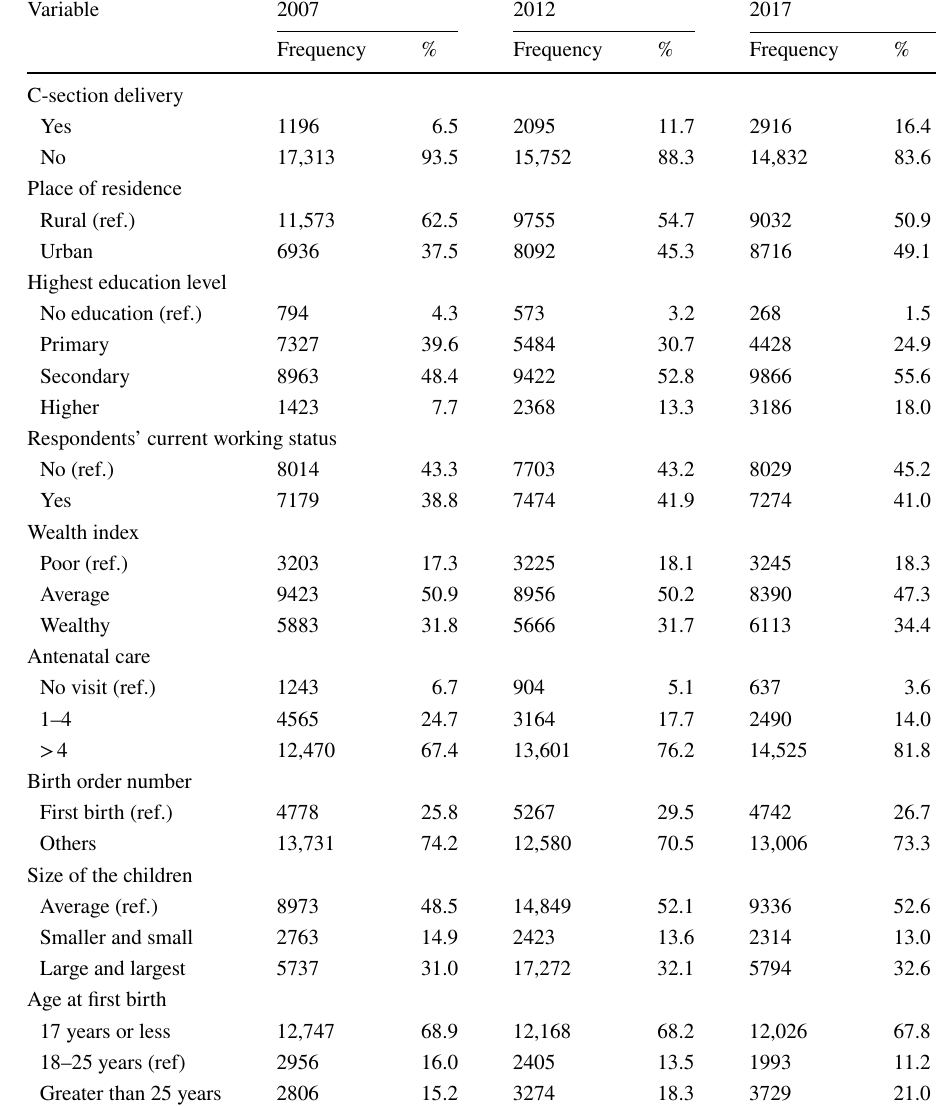
Table 1 Baseline characteristics for selected factors in three Demographic and Health Surveys (DHS), 2007–2017 in